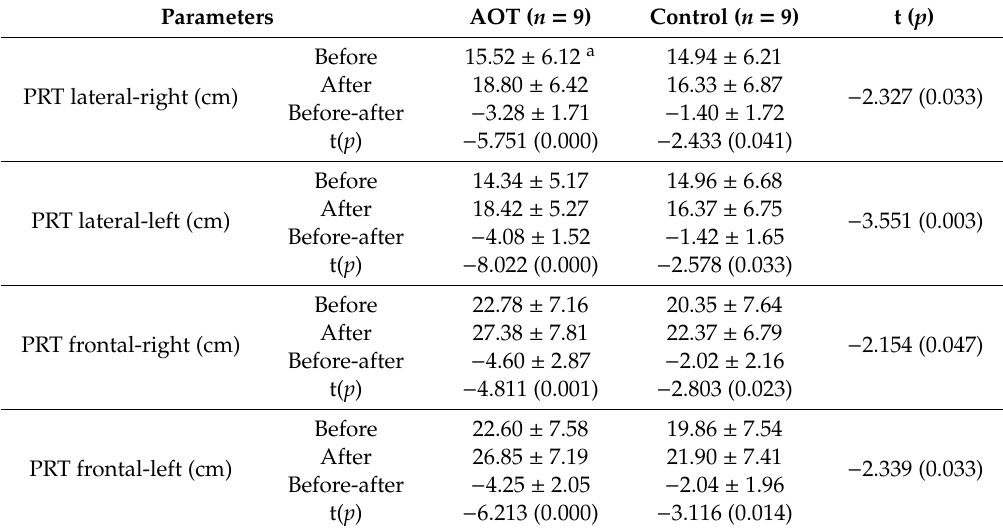
Table 5. Di ff erences in balance function ( N =